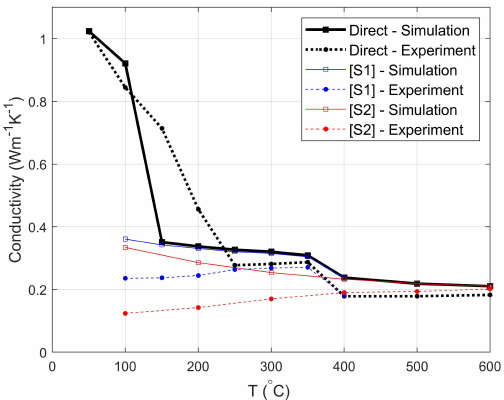
Figure 14. Effective conductivity measurements of [17,18], and corresponding results of simulations coupling the conductivity model with the pyrolysis simulation tool CALIF 3